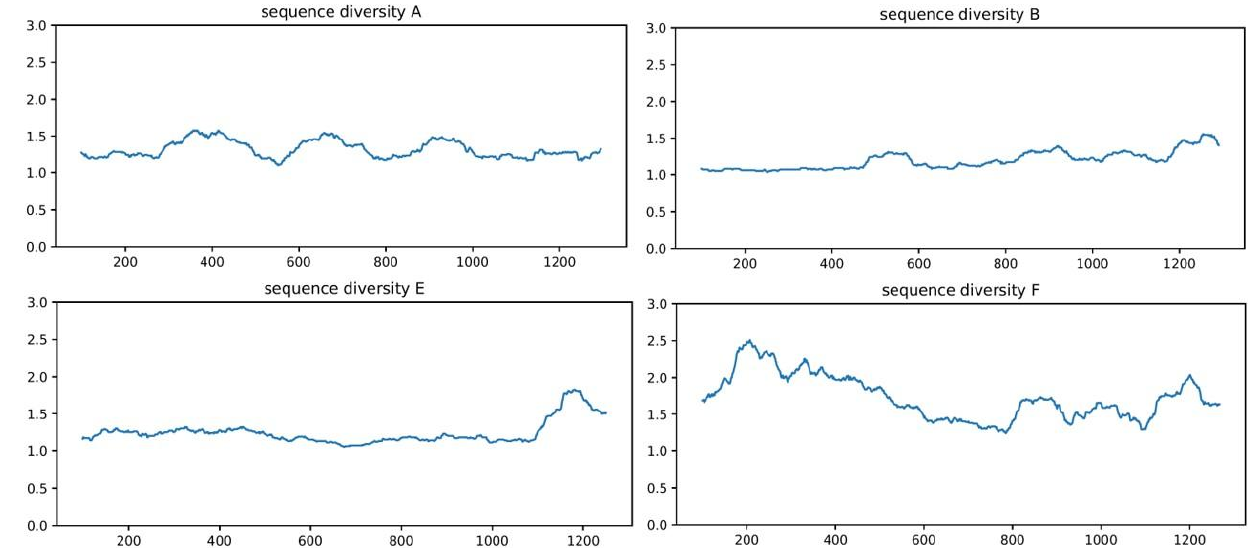
Figure 2. Protein sequence diversity within each type of BoNT. Protein sequences of each type were aligned and the diversity index (produced by counting the number of unique amino acids or nucleotides in each column in the multiple alignment files) of all of the positions were calculated and mapped onto a representative BoNT gene of each type. The moving average ( n = 100) of the diversity index was shown for an overview of the sequence variation.